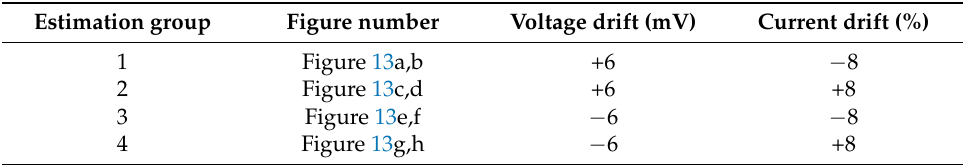
Figure 13. SOC estimation results obtained using three methods. Table 3. Voltage and current drift